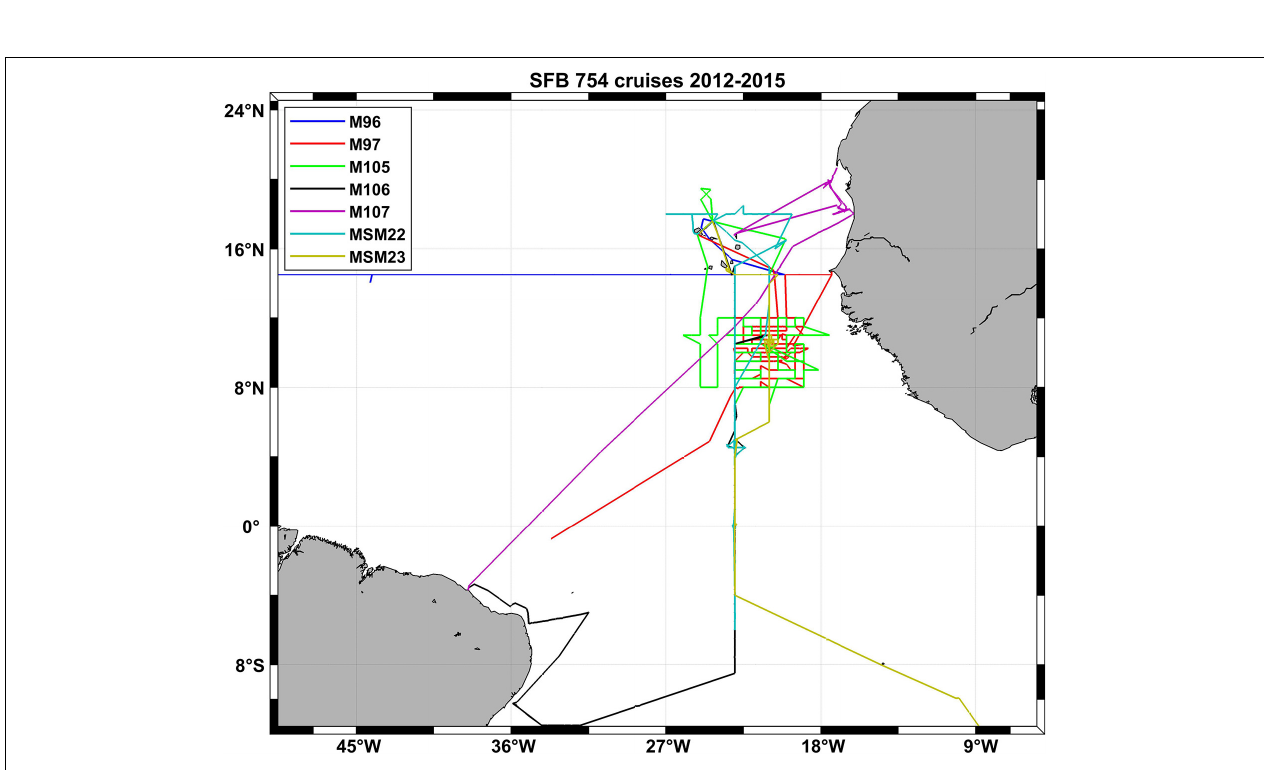
FIGURE 3 | Cruise tracks of seven SFB 754 cruises in the Atlantic Ocean in the second funding period of the project (2012–2015).